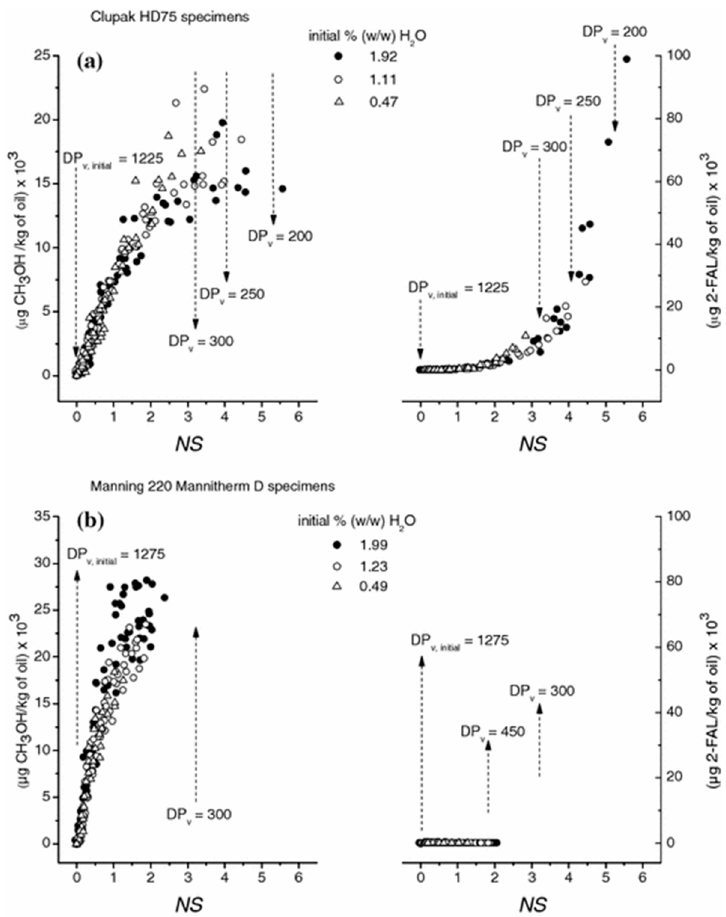
Figure 1. Comparison of the generation of methanol (CH 3 OH) and 2-FAL with cellulose scission number (NS): ( a ) standard Kraft paper, ( b ) TUK paper, from [1].